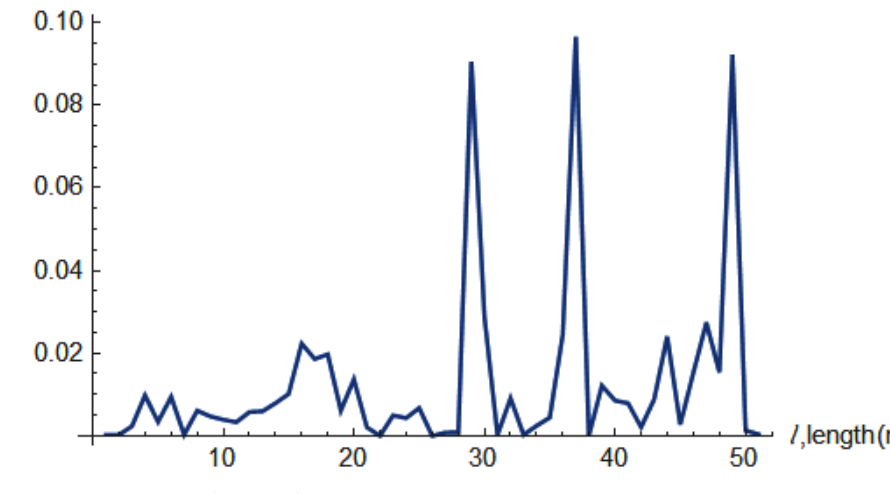
Figure 10. Curvature value